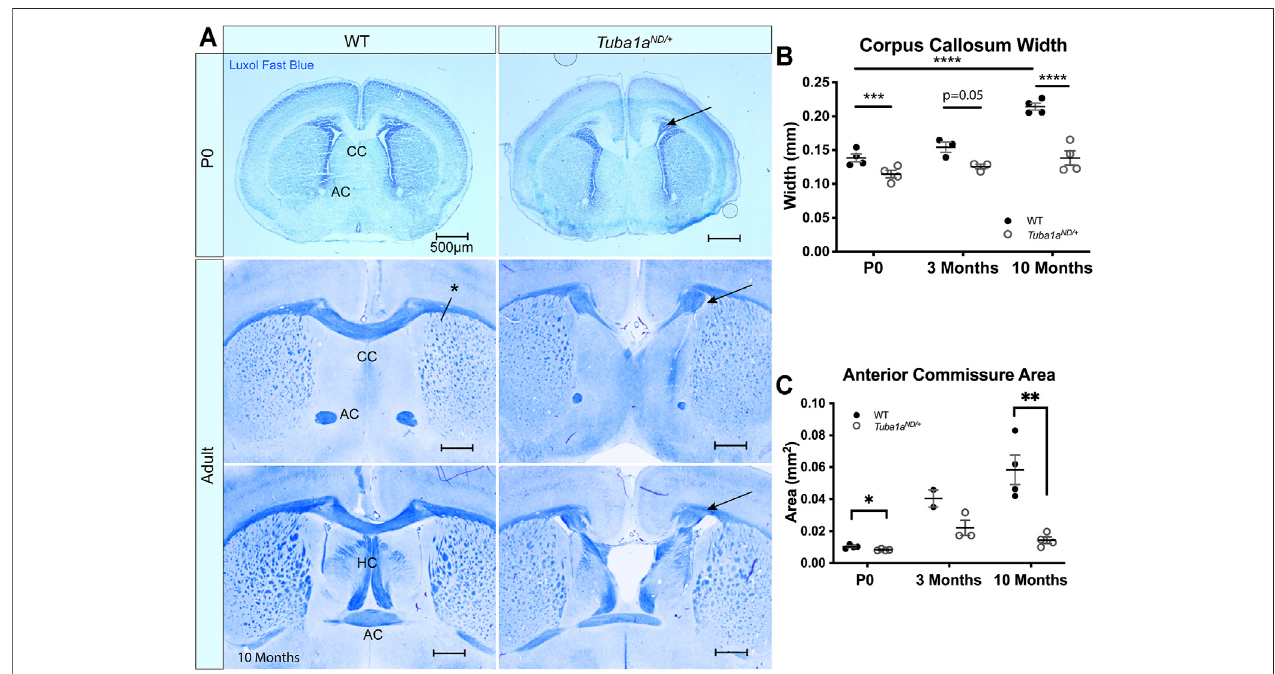
FIGURE3| Tuba1aisrequiredforformationofmidlinecommissuralstructures. (A) Luxolfastblue-stainedcoronalbrainsectionsfrompostnatalday0(P0;top)and Adult(middle-bottom)wild-typeand Tuba1a ND/+ mice.Imagesportrayabnormalmidlinecommissuralformationin Tuba1a ND/+ mousebrains,withlabelshighlightingthe corpus callosum (CC), anterior commissures (AC), and hippocampal commissure (HC). Scale bars are 500 μ m. Arrows indicate Probst bundles. Asterisk in A. shows where measurements for B . were obtained. (B) Scatter plot representing corpus callosum width at P0, 3 months, and 10 months-old. (C) Scatter plot displaying anterior commissure area in P0, 3 months, and 10 months-old wild-type and Tuba1a ND/+ brains. Wild-type and Tuba1a ND/+ measurements compared by two-way ANOVA. * p < 0.05; ** p < 0.01; *** p < 0.001; and **** p < 0.0001.